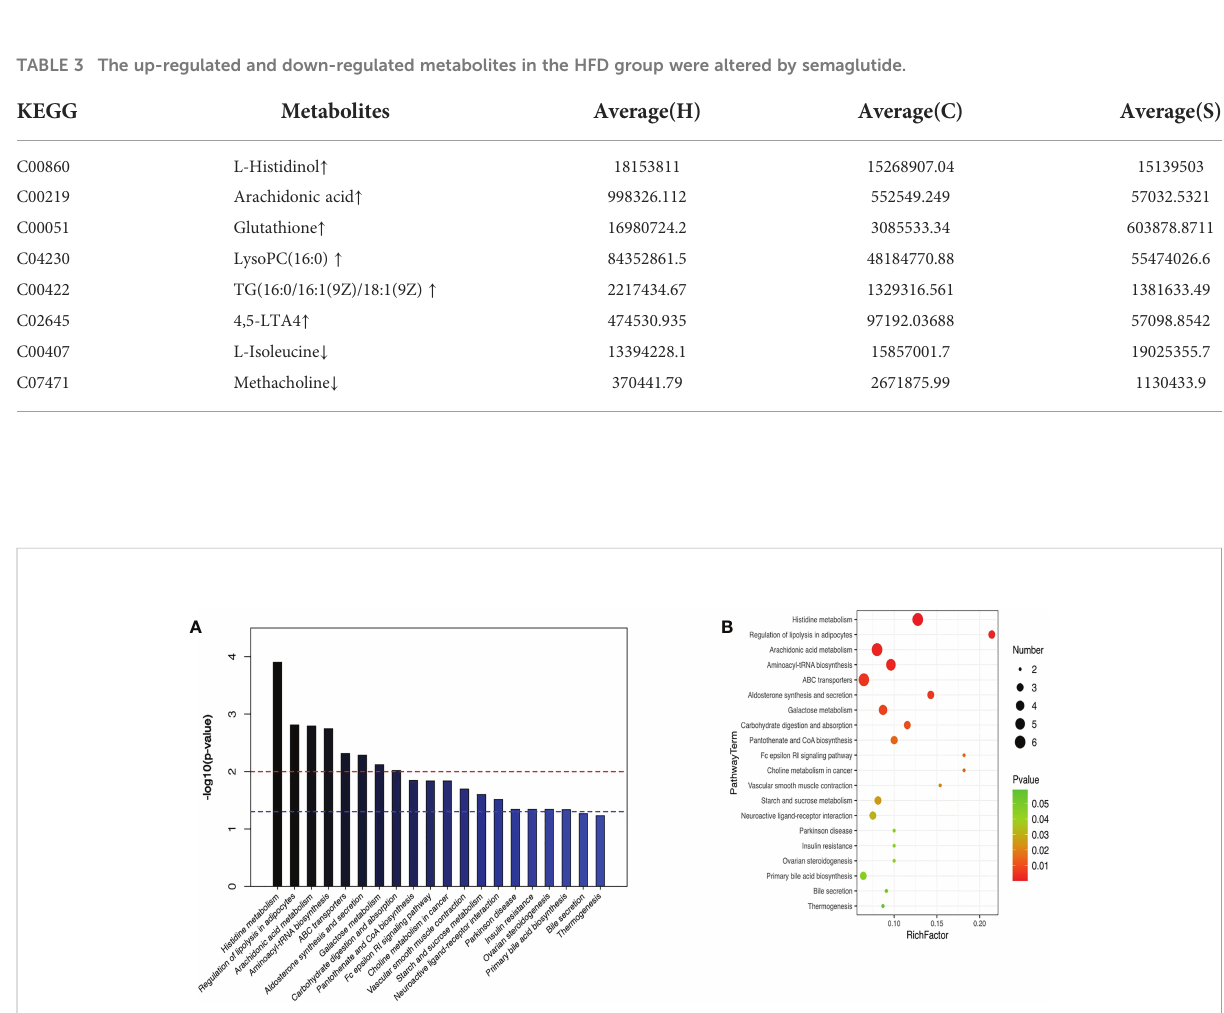
FIGURE 8 KEGG enrichment analysis stated the top ten hepatic pathways via bubble mapping. (A) A histogram (B) bubble mapping, KEGG, Kyoto Encyclopedia of Genes and